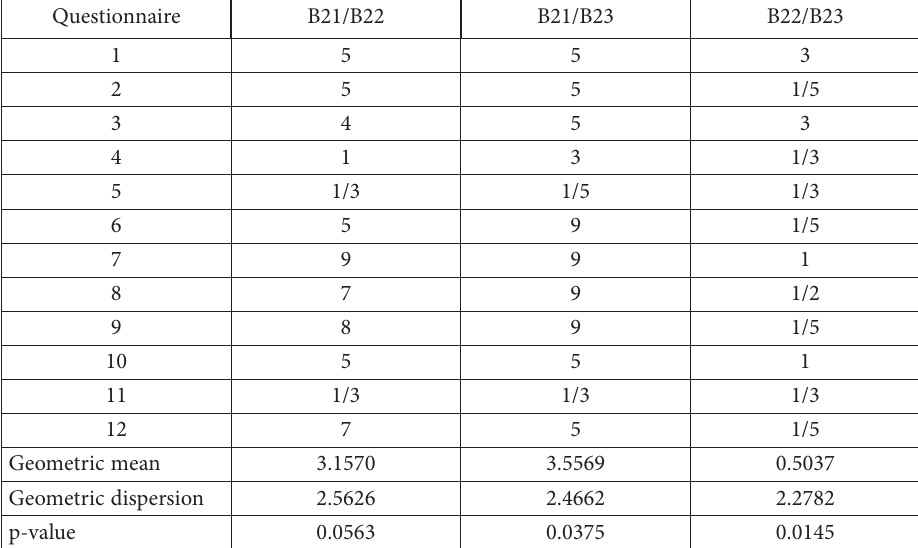
Table 6. Judgments, geometric means, and p -value of company status